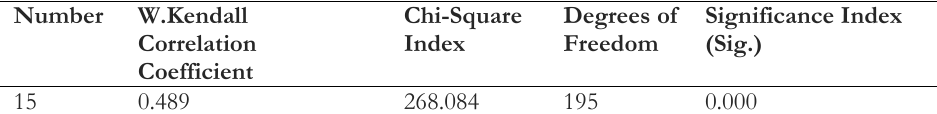
Table 3. Kendall W correlation test (Delphi third round) number of